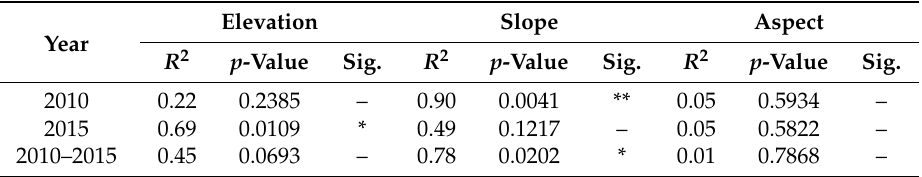
Figure 9. AGB/change within the stratified topography in Dinghai District: ( a ) AGB/change with elevation; ( b ) AGB/change with slope; ( c ) AGB/change with aspect; ( d ) radar chart of AGB/change with aspect. Table 6. Regression results between AGB/change and terrain features in Dinghai District.